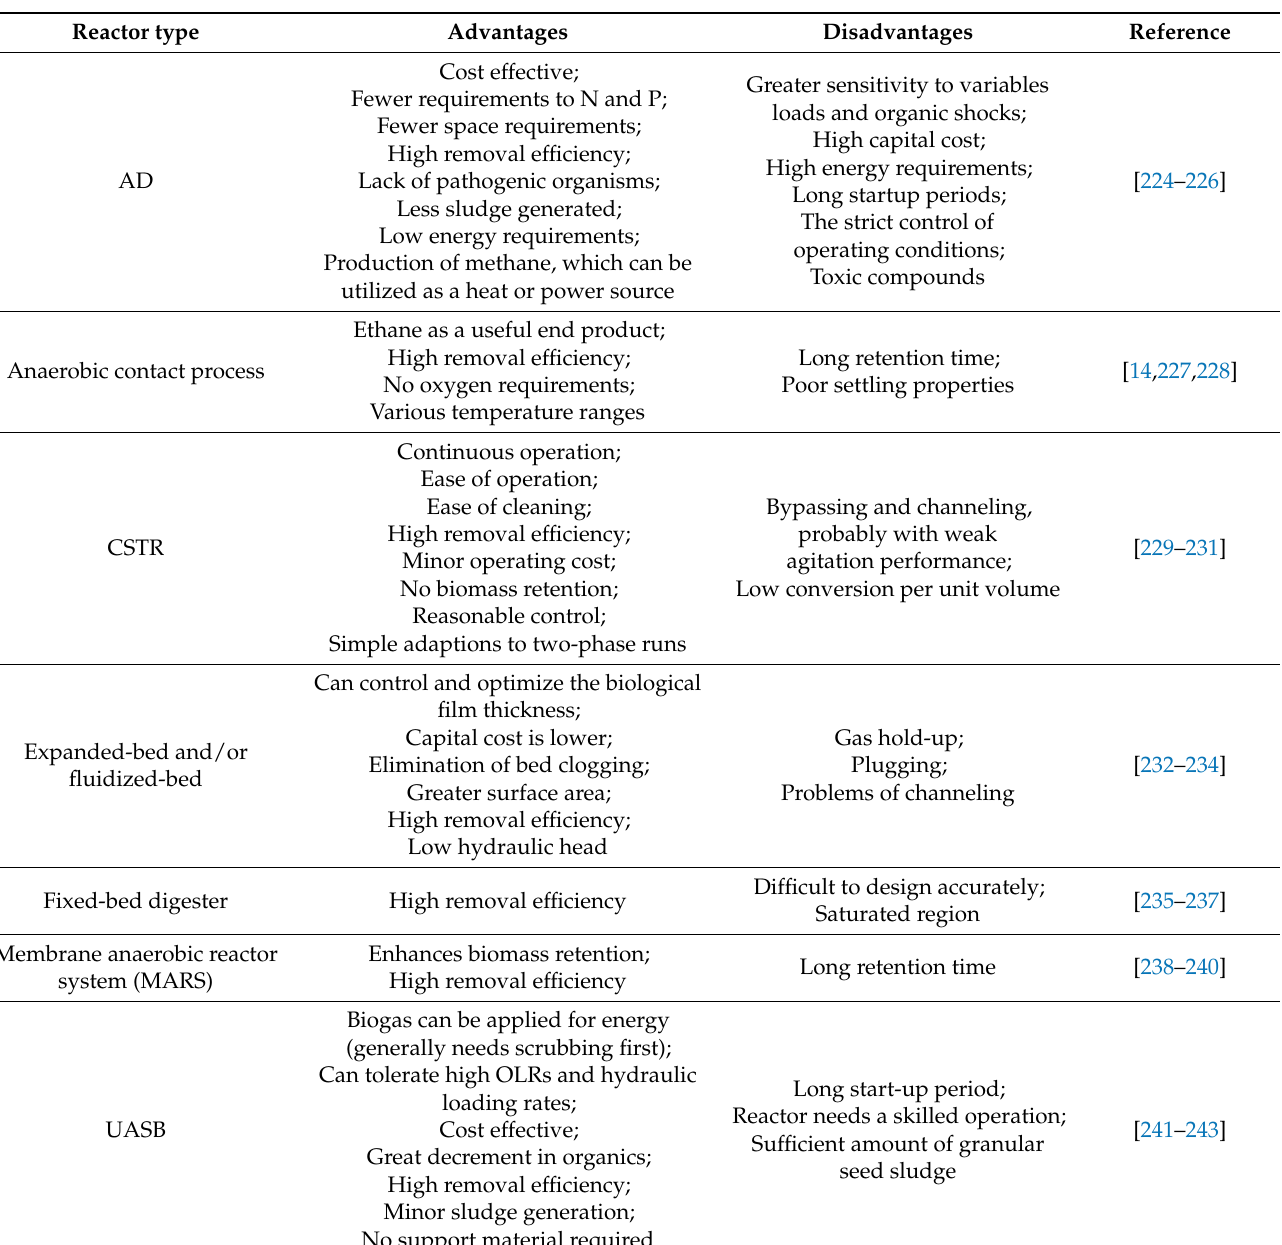
Table 7. Breakdown of strengths and weaknesses of prevailing anaerobic reactors (as indicated in the